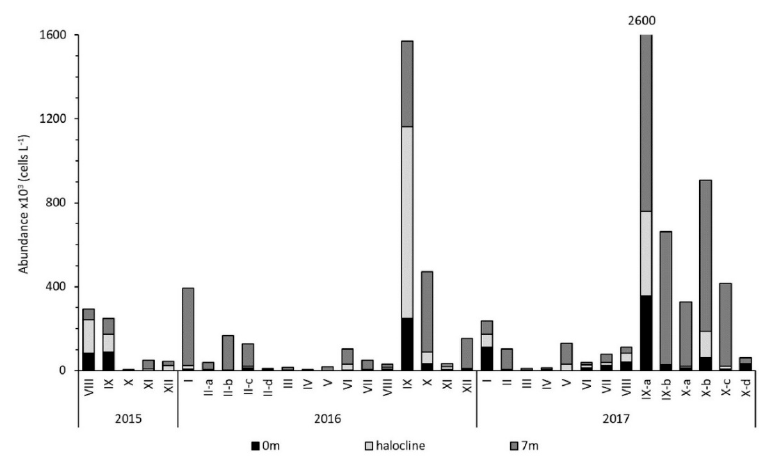
Figure 4. The abundance of Pseudo-nitzschia spp. at the surface, halocline, and 7 m depth, observed by light microscope (LM).